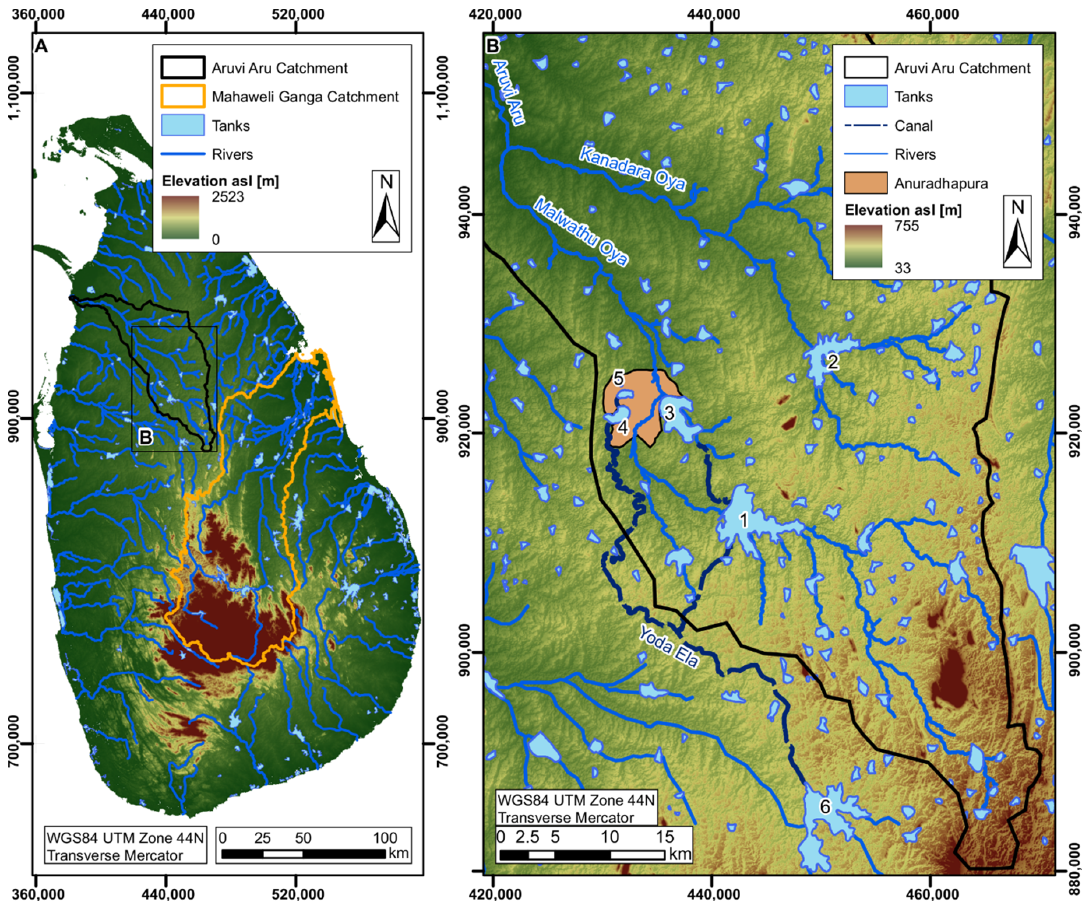
Figure 1. ( A ) Digital elevation model (DEM) of Sri Lanka, river network, location of the Aruvi Aru and Mahaweli Ganga catchments and study area; ( B ) DEM of the study area: the headwaters of the